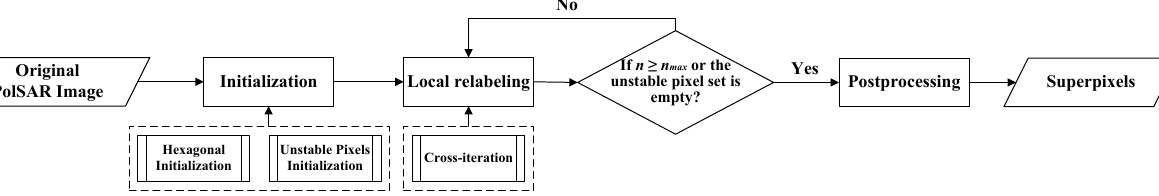
Figure 5. The flowchart of the proposed